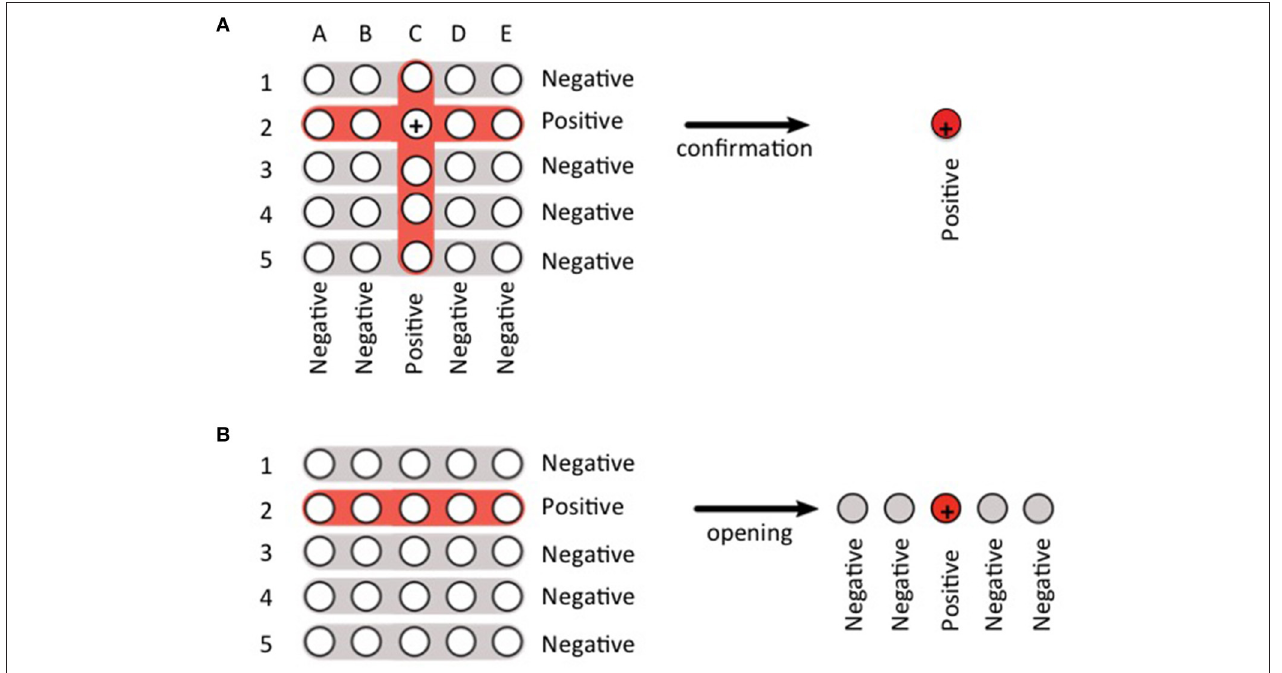
FIGURE 1 | Scheme of the two pooling strategies used in this work. (A) square matrix array. Here the samples are grouped in pools 1–5 representing rows, and in pools A–E representing columns. If pools 2 and C are positive, it is concluded that the third sample of pool 2, which is also the second sample of pool C, is positive ( + ). The result of this sample is confirmed by an individual test. (B) linear array. Here the positive pool (in this case, pool 2) must be opened to identify the positive sample ( + ).